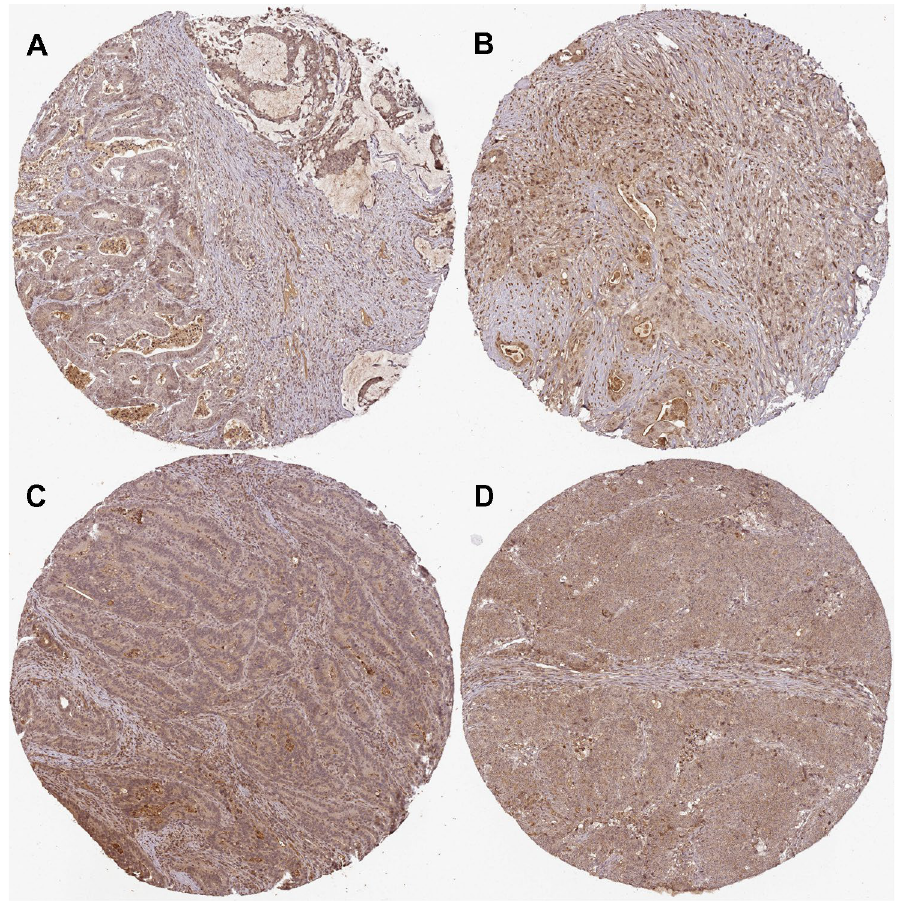
Figure 8. Pathological section images of expression of COL1A2 in CRC were taken from the Human Protein Atlas online database. See Table 7 for gene description.